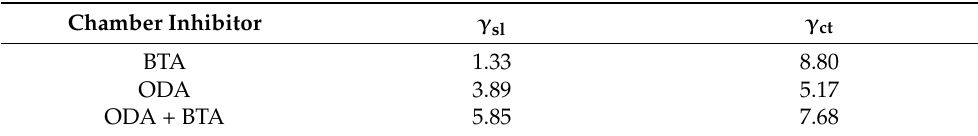
Table 6. Inhibition coefficients of chamber inhibitors by the blocking and activation mechanisms after different options of copper CT. T CT = 100 ◦ C, and τ CT = 60